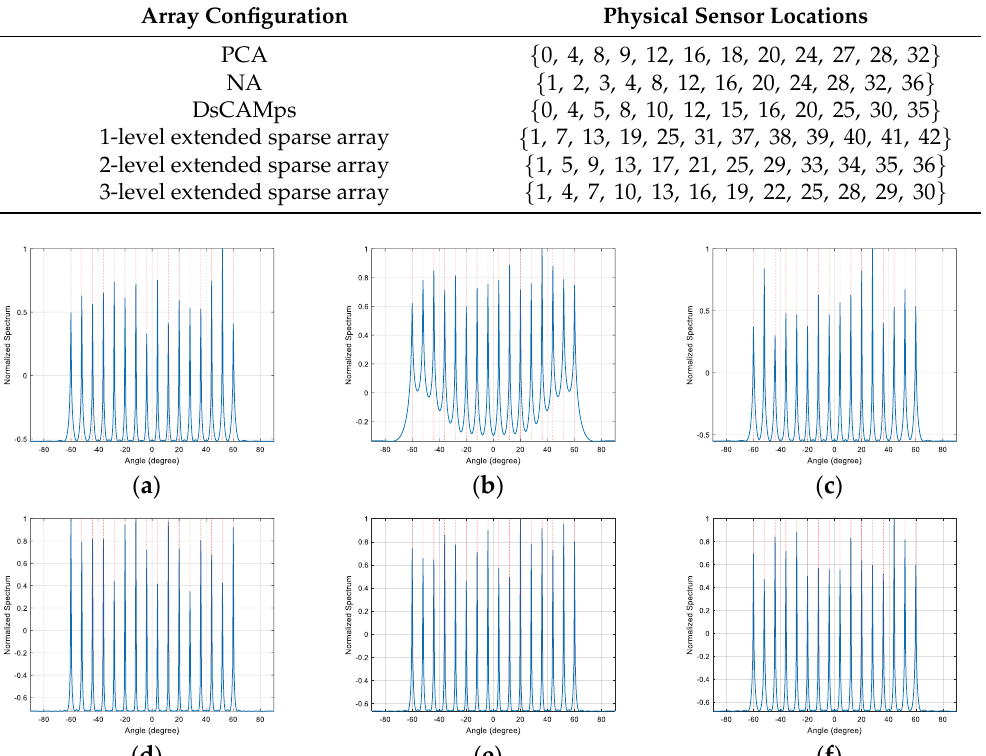
Table 1. Physical sensor locations.